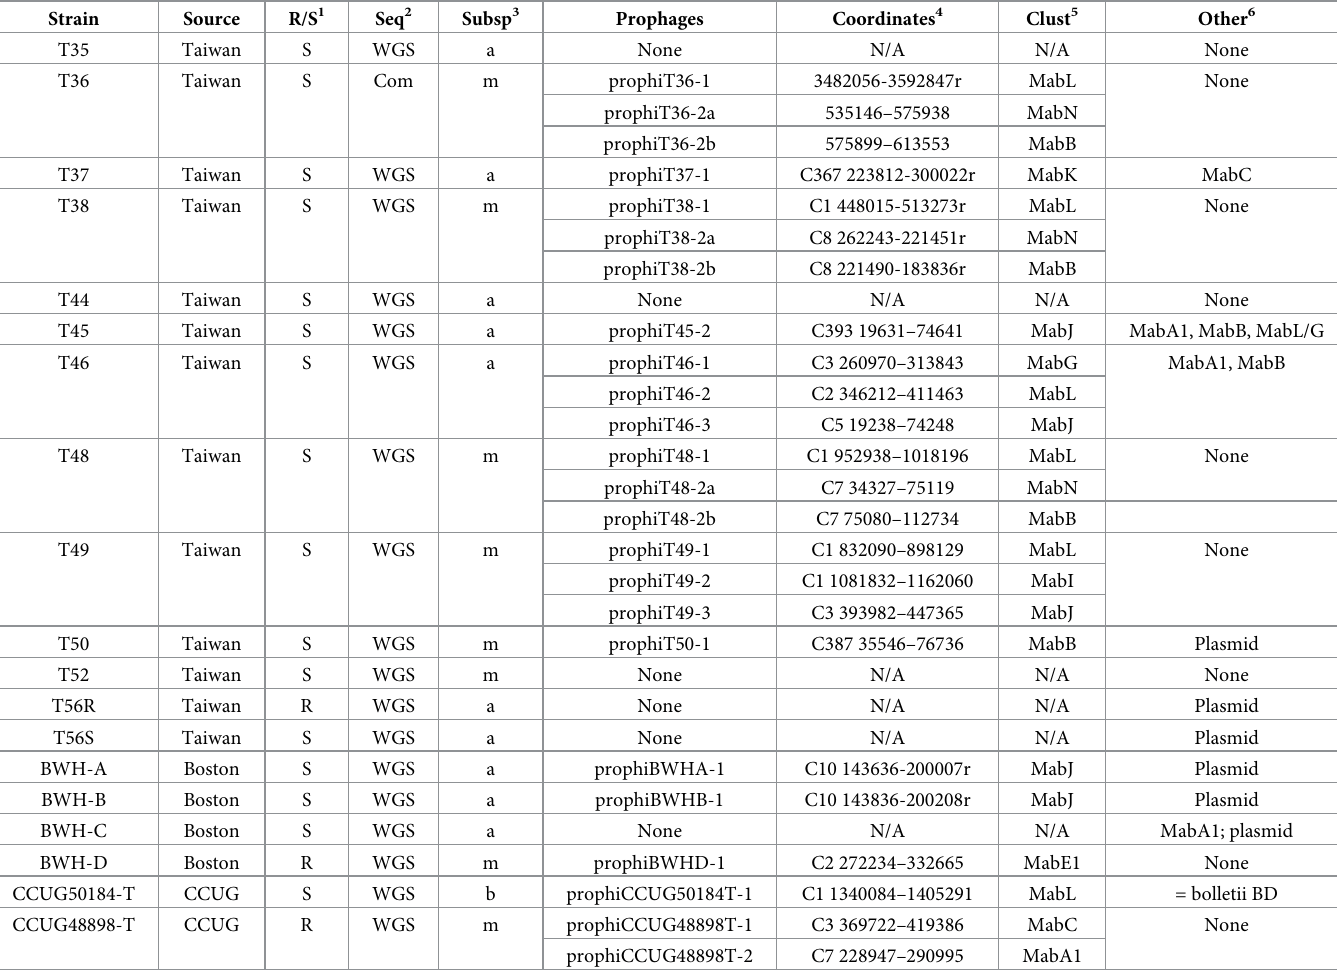
Table 1. M . abscessus strains and their